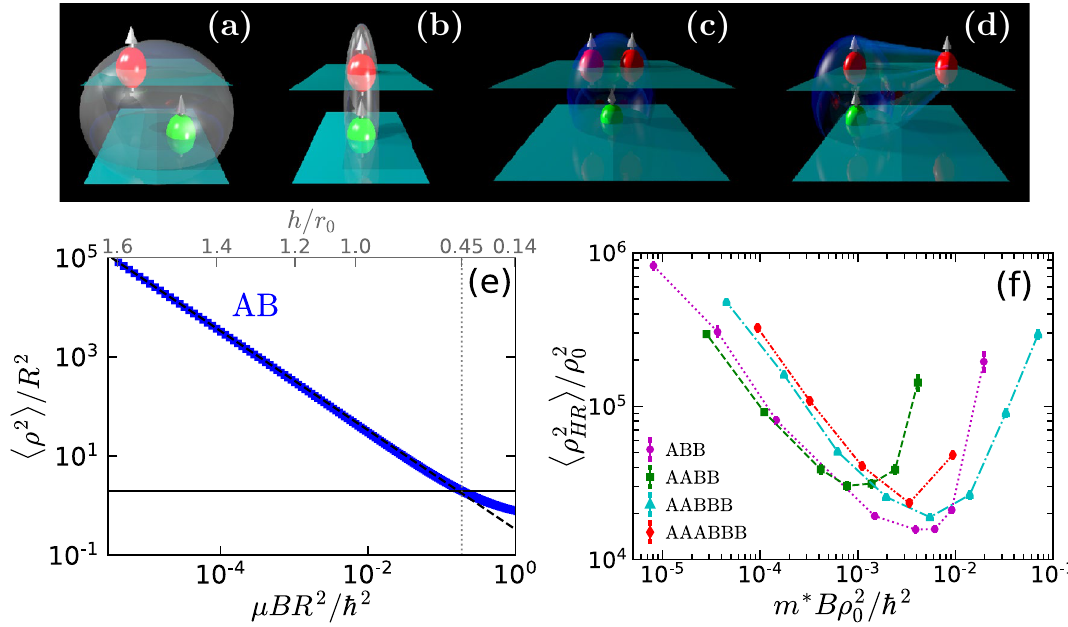
Figure 4. Top panel: Schematic representation of the AB and ABB states in two limits: ( a ) AB is a halo state; ( b ) h c . Figures created using POV-Ray (version 3.7) 41 . Bottom AB is not a halo state; ( c ) ABB h ; ( d ) ABB h → → ∞ ρ 2 / R 2 vs ground-state energy µ BR 2 / (cid:31) 2 scaling plot for two-body halos. The horizontal line is panel: ( e ) Size (cid:31) (cid:30) (cid:31) 2 /( 3 µ BR 2 ) , which is a zero-range approximation for ρ 2 / R 2 the quantum halo limit and the dashed one is � � = ρ 2 /ρ 2 0 vs ground-state energy m ∗ B ρ 2 0 / (cid:31) 2 scaling plot for three- two-body halos in two-dimensions 12 . ( f ) Size HR (cid:30) (cid:31) up to six-body